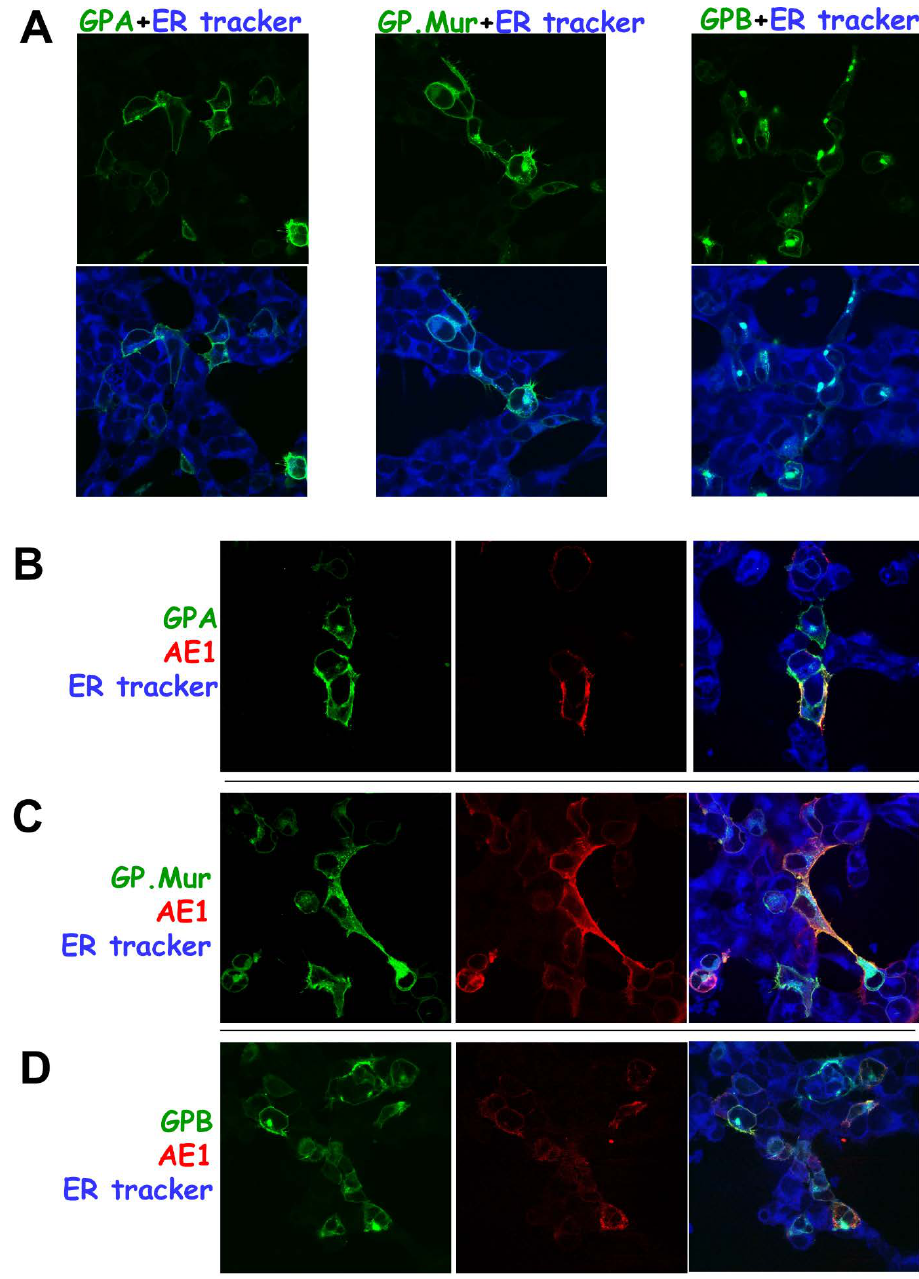
Figure 4. Different from GPA and GP.Mur with substantial surface expression, singly expressed GPB was much retained in the ER but could be driven to the cell surface upon AE1 coexpression. ( A ) TOP: Expression of the fluorescent fusion GPAyfp alone (left), GPMURgfp alone (middle), and GPBgfp alone (right). BOTTOM: Overlay of each glycophorin-fluorescent fusion protein with the blue-fluorescent ER tracker. ( B ) HEK-293 cells cotransfected with equimolar pGPAyfp and pcAE1 were fixed and permeabilized on the second day post-transfection for immunofluorescence labeling of AE1 in red (mixed BRIC 6 + BRIC 71 + BRIC 170 mAb [1:500 dilution each] followed by anti-mouse IgG conjugated Alexa fluor 568 [1:200 dilution]). ( C ) HEK-293 cells were cotransfected with equimolar pGPMURgfp and pcAE1, followed by the same staining protocol as in ( B ). ( D ) HEK-293 cells were cotransfected with equimolar pGPBgfp and pcAE1, followed by the same staining protocol as in ( B ). In ( B – D ), the left panel showed expression of the glycophorin-fluorescence fusion protein (in green color) upon AE1 coexpression; the middle panel showed expression of AE1 (in red color) upon glycophorin coexpression; the right panel showed the merged fluorescent signals of the glycophorin fusion (green), AE1 (red) and the ER tracker